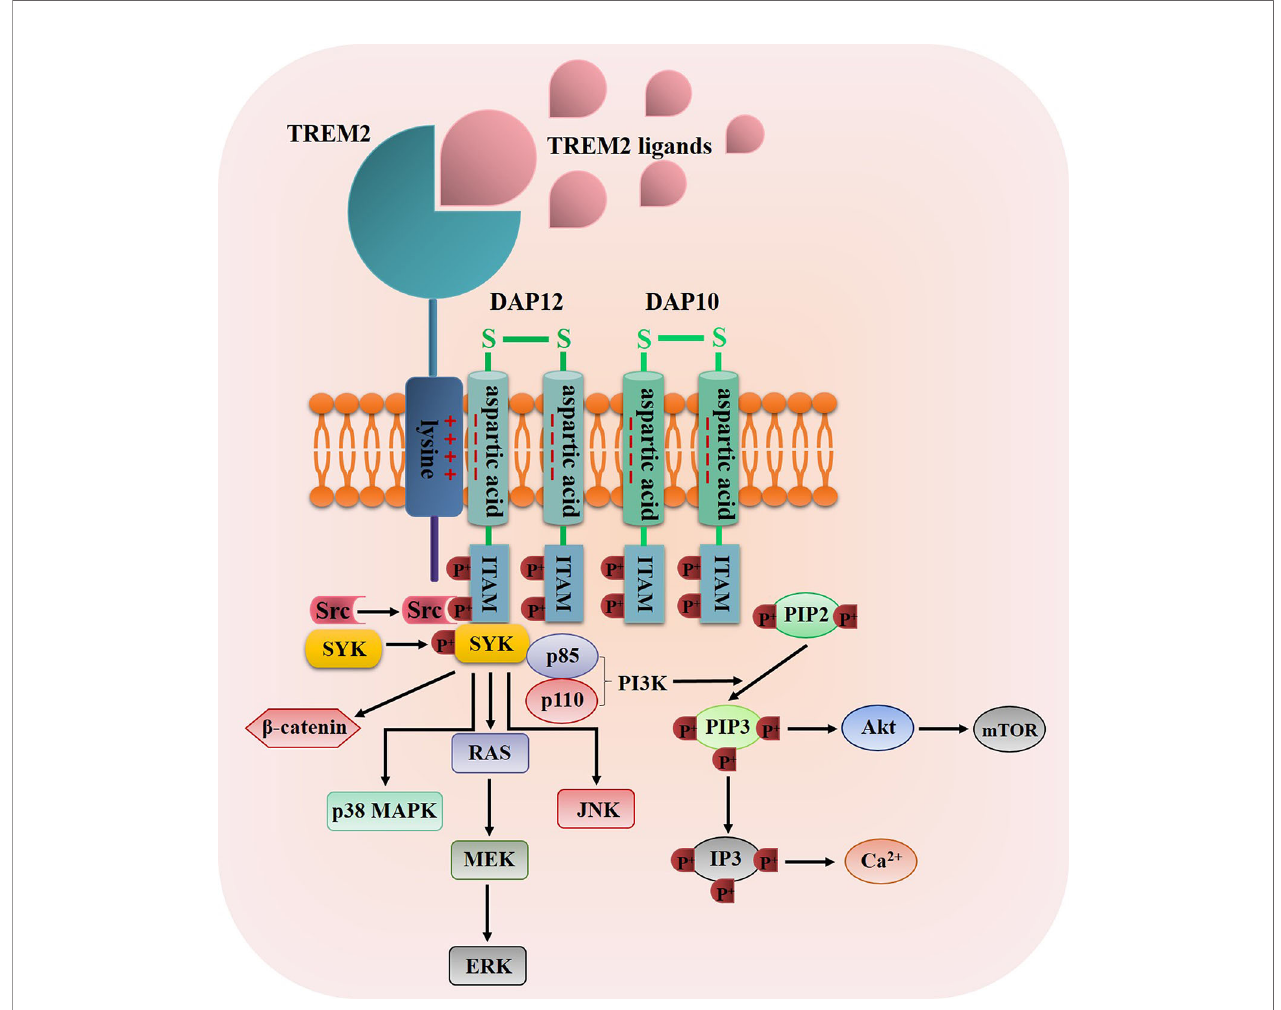
FIGURE 2 | The diagrammatic view of TREM2 signaling pathway. Once TREM2 binding to one of its ligands such as bacterial products, DNA, LDL, Apo E and A b , the TREM2 signaling pathway was propagated through the interaction of TREM2 and DAP12/DAP10 via oppositely charged residues, thus resulting in the tyrosine phosphorylation of DAP12/DAP10 within its ITAMs by Src tyrosine kinases, then SYK was recruited and phosphorylated by the ITAM regions to activate some downstream signaling molecules such as PI3K, Akt, mTOR, p38 MAPKs, ERK, JNK and b